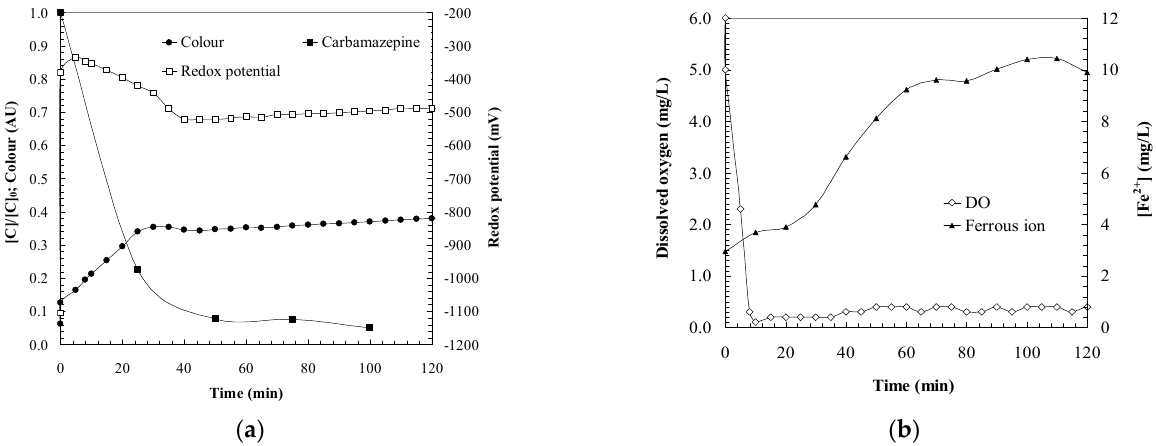
Figure 1. Water quality parameters analysed during carbamazepine oxidation by photo-Fenton: ( a ) Carbamazepine concentration, colour and redox potential. ( b ) Dissolved oxygen and ferrous ion. Experimental conditions: [CBZ] 0 = 50.0 mg/L; pH = 3.0; [H 2 O 2 ] 0 = 2.0 mM; [Fe] 0 = 10.0 mg/L; [UV] = 150 W; T = 40 °C.